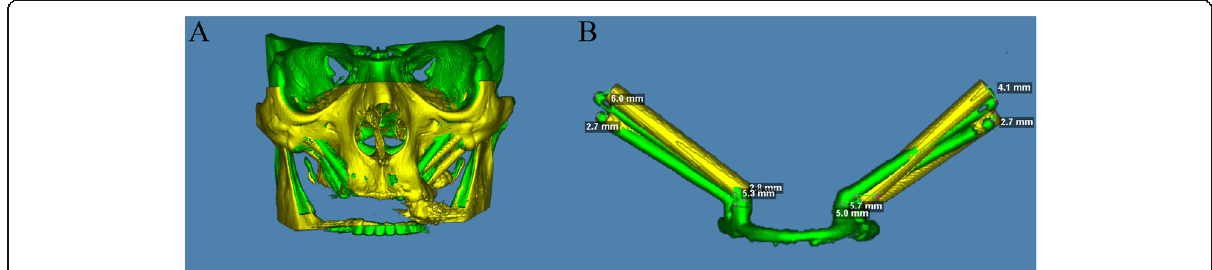
Fig. 2 DICOM files overlayering and zygomatic implants isolation